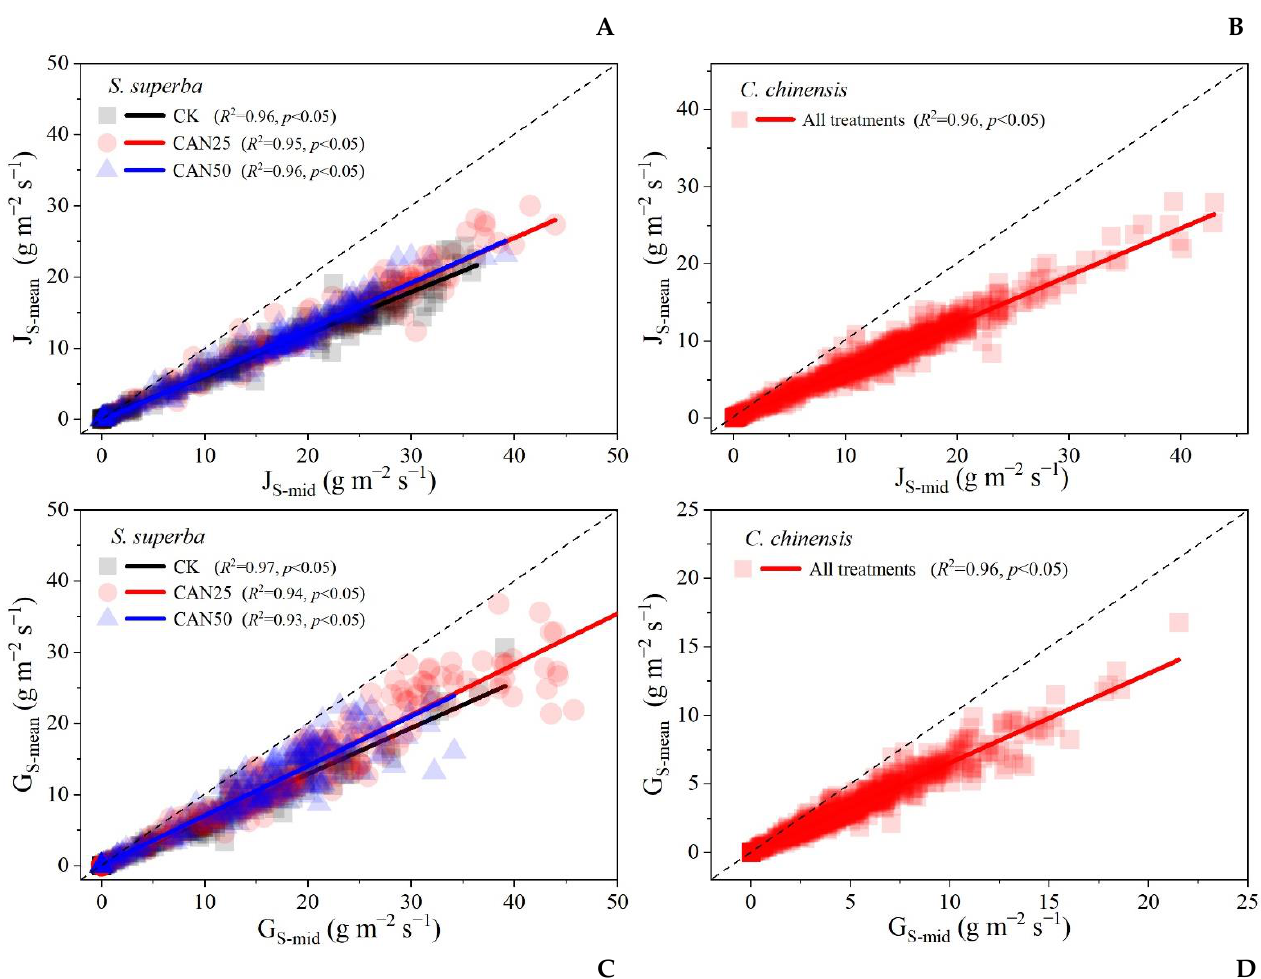
Figure 5. The mid-day J S (J S-mid ) fitted daily mean J S (J S-mean ) and the mid-day G S (G S-mid ) fitted daily mean G S (G S-mean ) for S. superba ( A , C ) and C. chinensis ( B , D ) under different nitrogen addition treatments. ANCOVA indicated that the differences of slopes under five nitrogen addition treatments were only significant for S. superba .